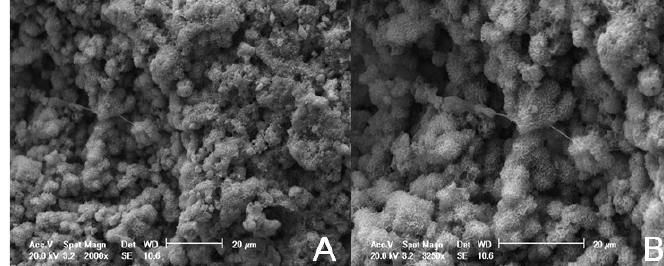
FIGURE 3 - Scanning electron micrography of cells adhered to the macroporous CPC surface on the fifth day of culture. A) Magnification of 2000x, B) Magnification of 3250x.